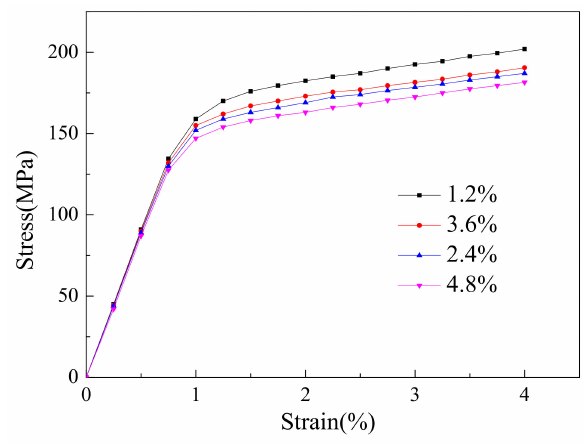
Figure 4. Stress-strain curves of GRANs with di ff erent